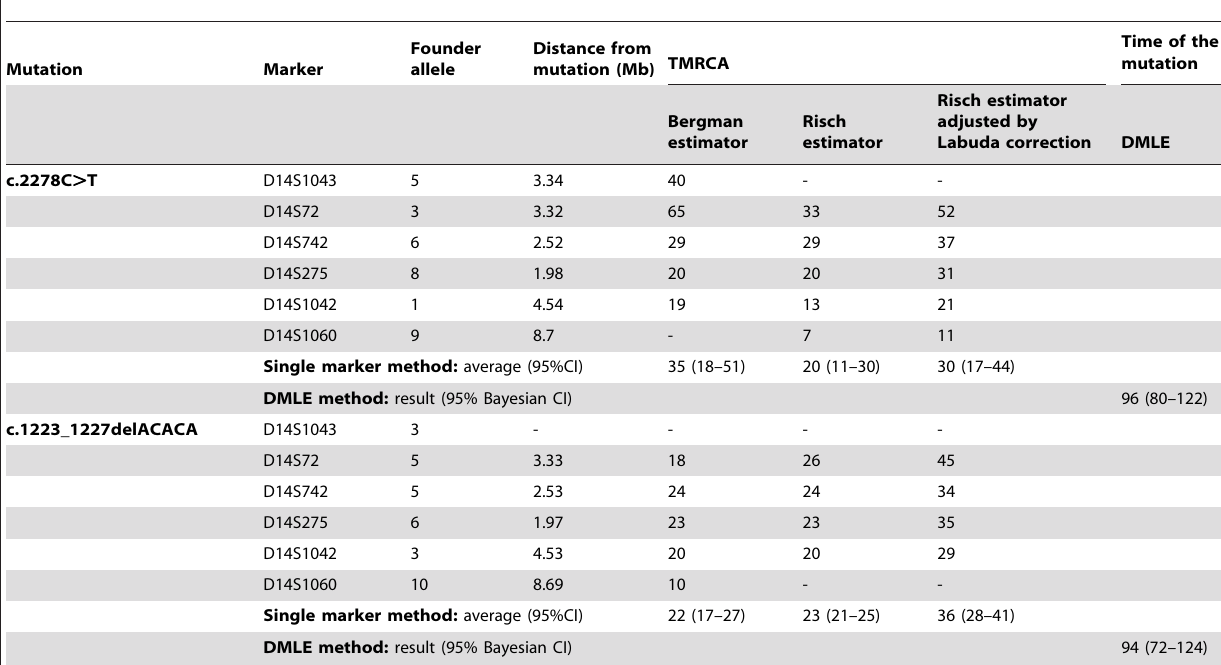
Table 2. Estimation of the TMRCA and the age (generations) of the c.2278C . T and c.1223_1227delACACA mutations by Risch et al, Bergman et al. and the DMLE